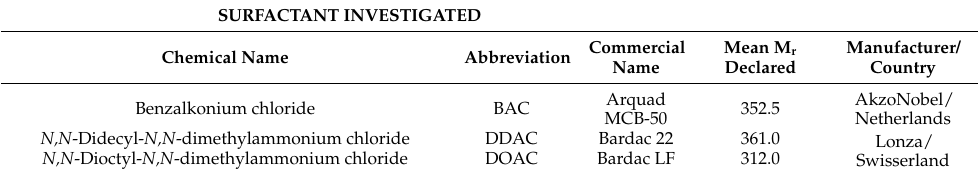
Table 1. The chemical names, abbreviations, commercial names, and declared mean M r of three technical grade cationic surfactants